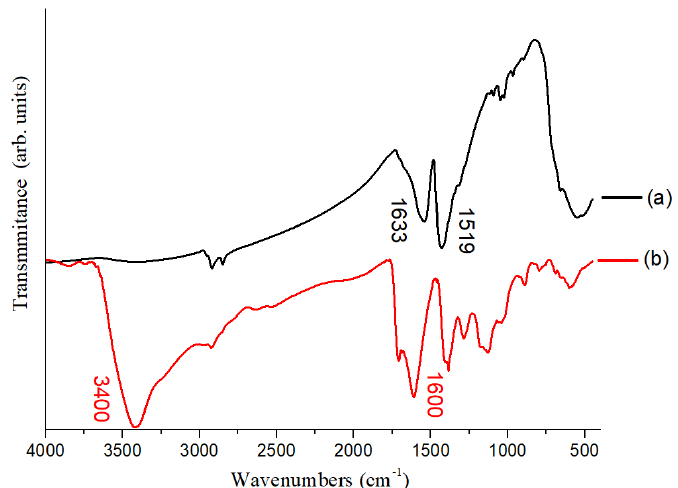
Figure 7. The Fourier-transform infrared spectroscopy (FTIR) patterns of ( a ) water soluble FePt NPs and ( b ) oil soluble FePt NPs.